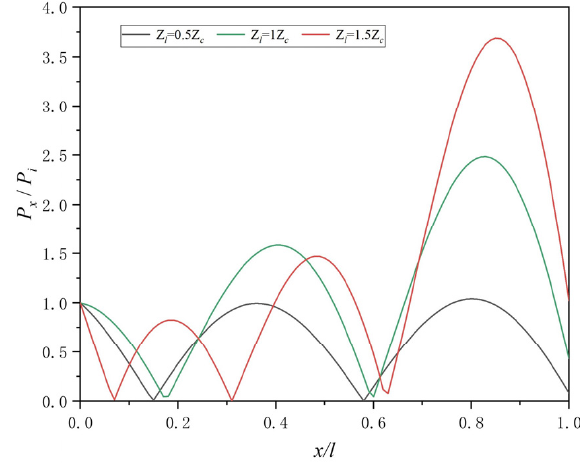
Figure 14. Effect of tube terminal impedance on fluctuations.